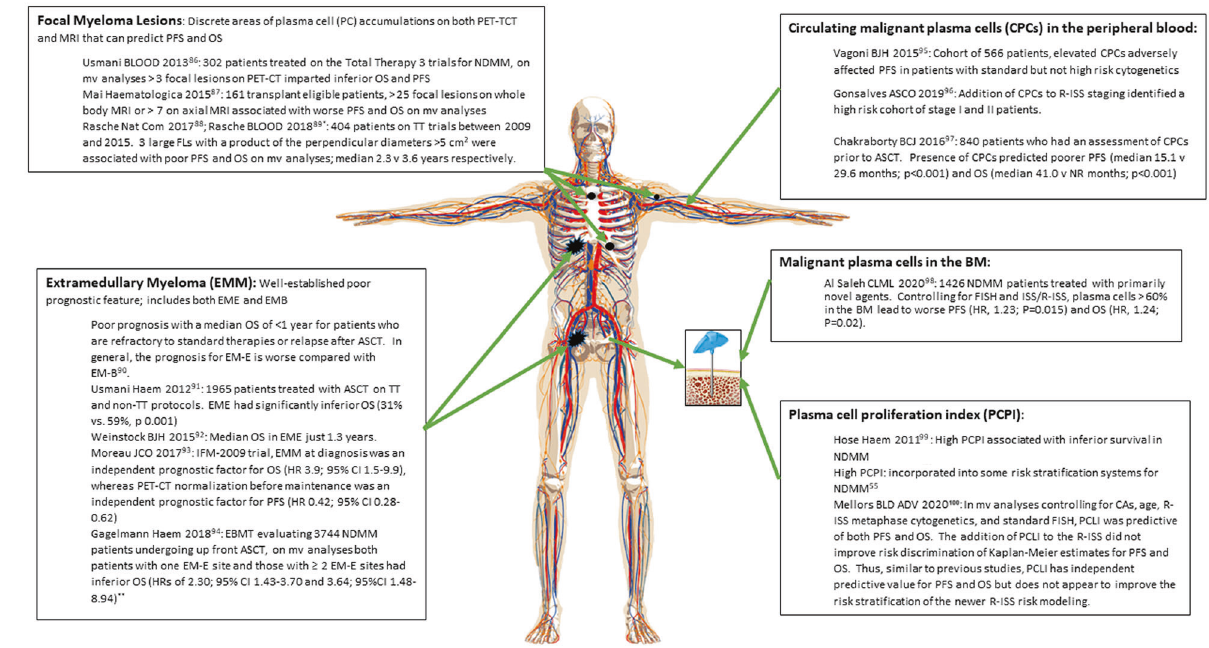
Fig. 1 High-risk clinical features. * Large FLs (diameter >2.5 cm) associated with site-speci fi c enrichment of HiR driver mutations consistent with them being key mediators of drug resistance and treatment failure [86 – 100]. ** Certain EME sites seemed to carry worse prognosis with 3-year PFS differing according to involved organs: kidney (59.5%), skin (20.1%), lymph nodes (37.6%), CNS (47.9%), lung/respiratory tract (44.4%), GI/liver (22.5%), and spleen, ovaries, and testes (60.0%). BM bone marrow, CA cytogenetic abnormalities, CPCs circulating plasma cells, EBMT European Society for Blood and Marrow Transplantation, EME extramedullary myeloma that is extra-osseous (results from hematogenous spread and involving only soft tissues, the incidence in NDMM 1.7 – 3.5% 90 ), EMB extamedullary myeloma that is paraskeletal or paraosseous plasmacytomas (consists of tumor masses adjacent to bones and arising from focal skeletal lesions, incidence in NDMM 6 – 34.4% 90 ), EMM extramedullary myeloma, FL focal lesion, HR hazard ratio, ISS international staging system, MRI magnetic resonance imaging, MV multivariate, NDMM newly diagnoses multiple myeloma, NR not reached, OS overall survival, PC plasma cells, PCPI plasma cell proliferation index, PET-CT 18- fl uoro-deoxyglucose emission tomography, PFS progression-free survival, R-ISS revised international staging system, TT total